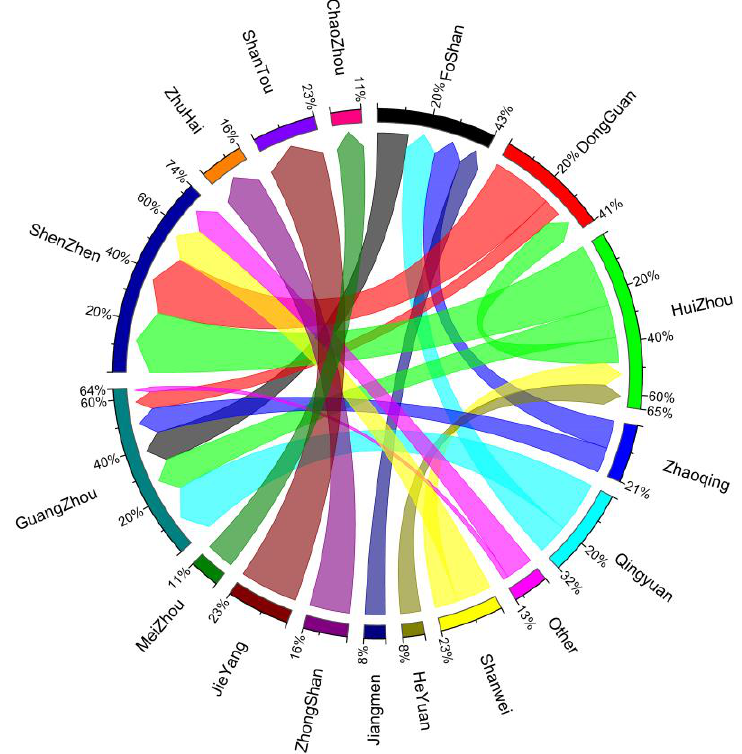
Figure 10. Power transfer of Guangdong Province in 2021.